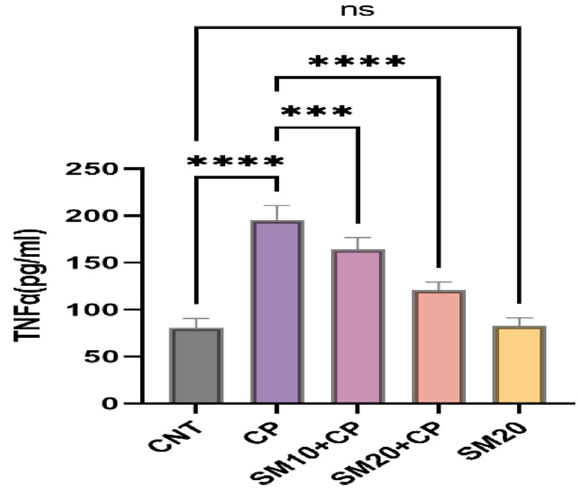
Figure 2. Protective effects of SM on renal inflammatory cytokine (TNF α ) level against CP-dependent nephrotoxicity. Value denoted in mean ± SD (n = 6). **** p < 0.0001 vs. CNT, *** p < 0.001 vs. CP, **** p < 0.0001 vs CP and ns p > 0.05 vs. CNT,. Abbreviation; CNT: control, CP: cyclophosphamide, SM: sesamin, TNF α : tumor necrosis factor alpha.